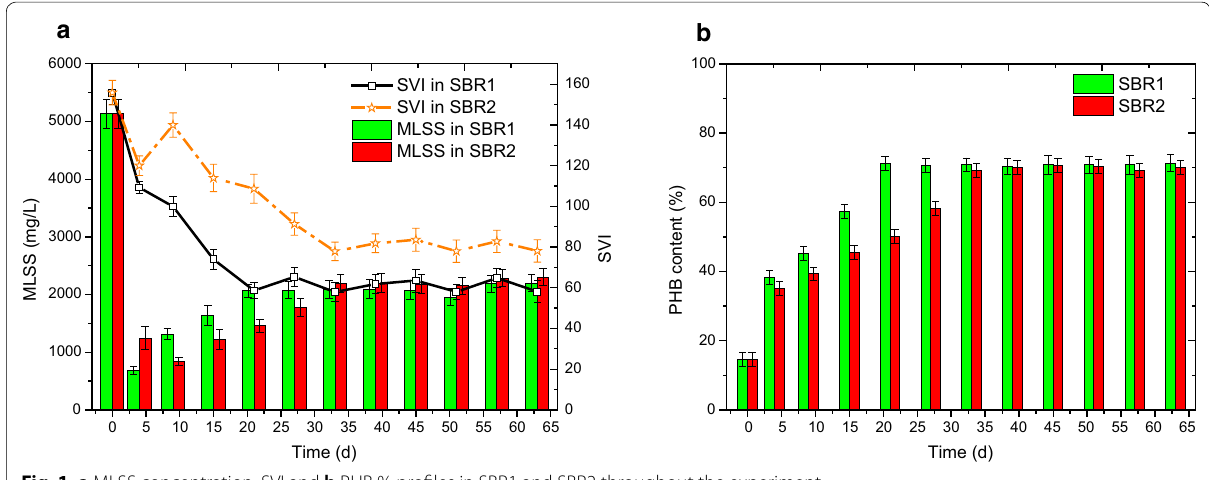
Fig. 1 a MLSS concentration, SVI and b PHB % profiles in SBR1 and SBR2 throughout the experiment